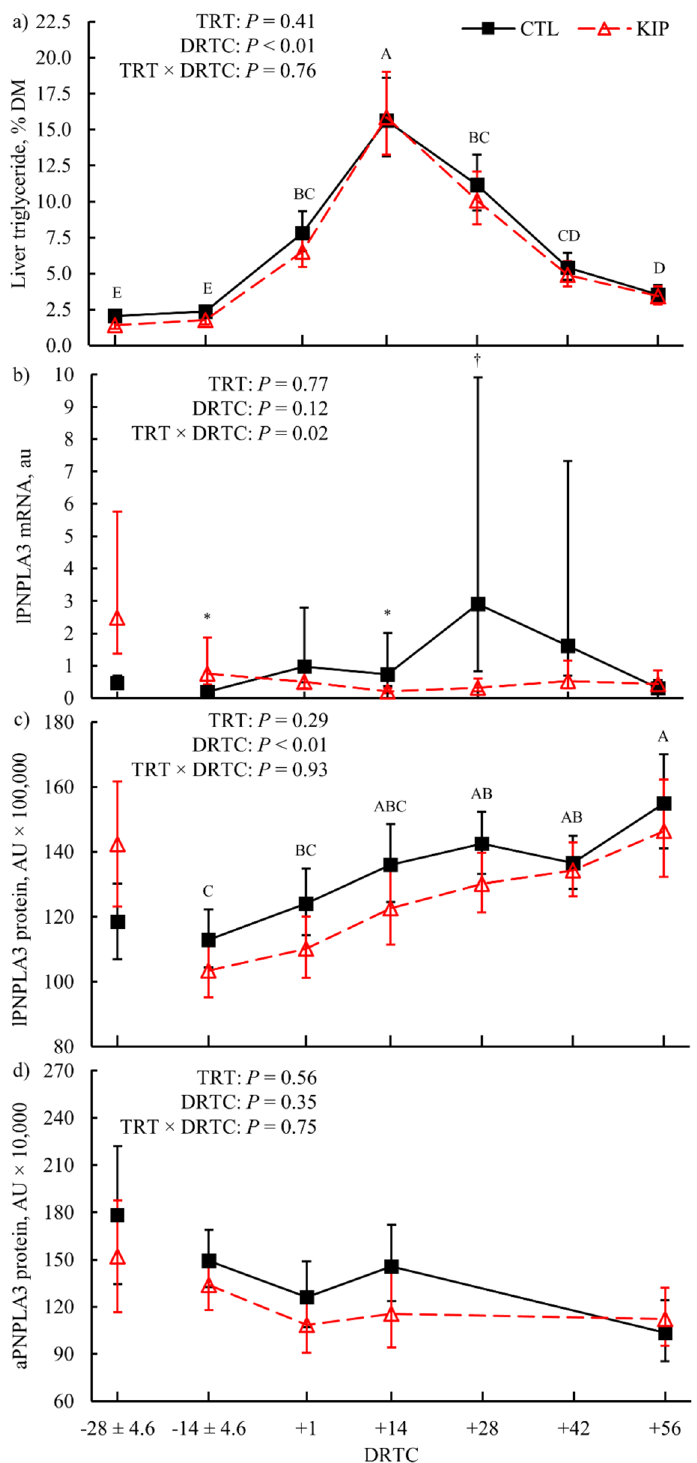
Figure 4. Liver triglyceride ( a ), liver patatin-like phospholipase domain-containing protein 3 (lPNPLA3) mRNA expression ( b ), lPNPLA3 protein abundance ( c ), and adipose PNPLA3 (aPNPLA3; d ) protein abundance during the experimental period for control (CTL) and ketosis induction protocol (KIP) treatments (TRT). The − 28 expected days relative to calving (DRTC) values were included as model covariates for their respective responses ( b – d ); values graphically represented for − 28 expected DRTC are the arithmetic means. Variance in the actual DRTC sampled is represented for the relevant prepartum timepoints (± standard deviation). Error bars represent the 68% confidence limits of the least squares or arithmetic mean. Symbols represent significant (* P ≤ 0.05) and marginal ( † 0.05 < P ≤ 0.10) simple effect differences for treatment × time interactions after multiplicity correction (Bonferroni). Differences across expected days relative to calving (DRTC; P ≤ 0.05, Tukey’s adjustment) are indicated when alphabetic superscripts do not share